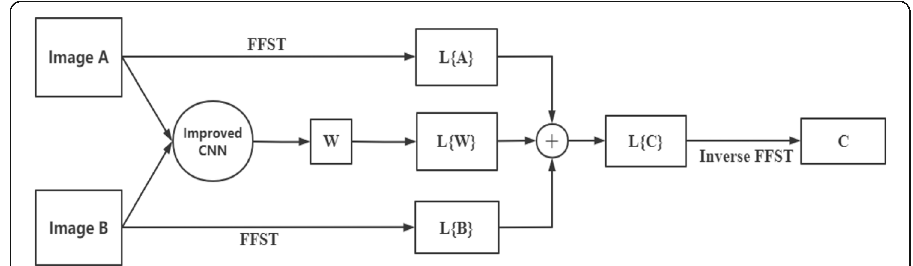
Fig. 4 flow chart of fusion image in Space-Ground-Sea Wireless